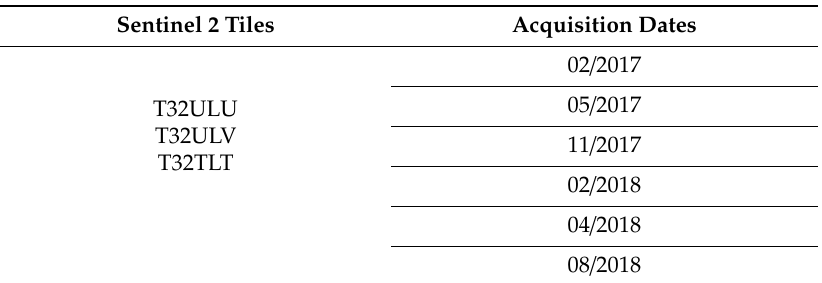
Table 2. Image acquisition dates of the Sentinel 2 remote-sensing data.